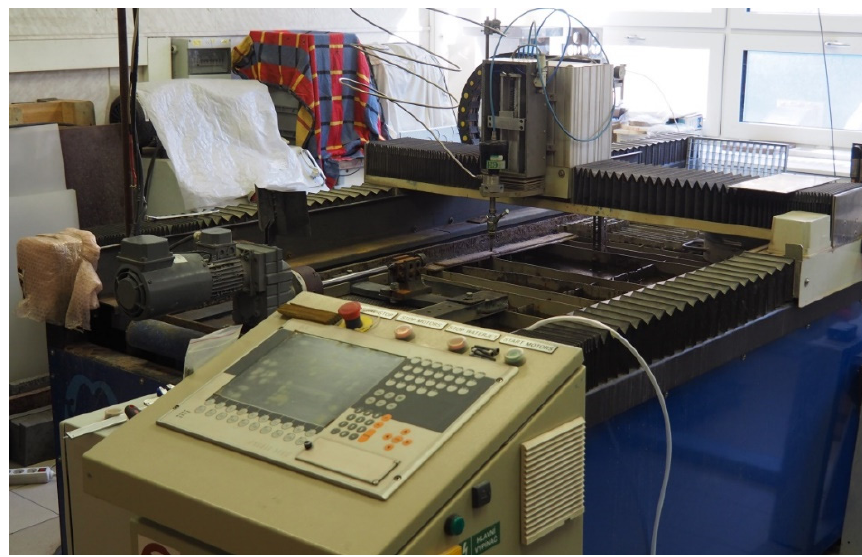
Figure 2. Abrasive waterjet laboratory with PTV WJ1020-1Z-EKO device.